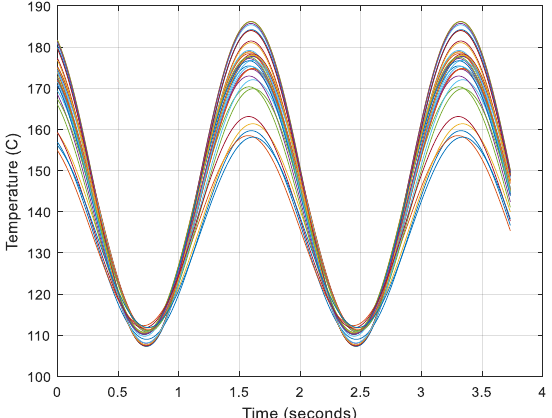
Figure 9. Sensor temperature for turn-to-turn short circuit in each slot.